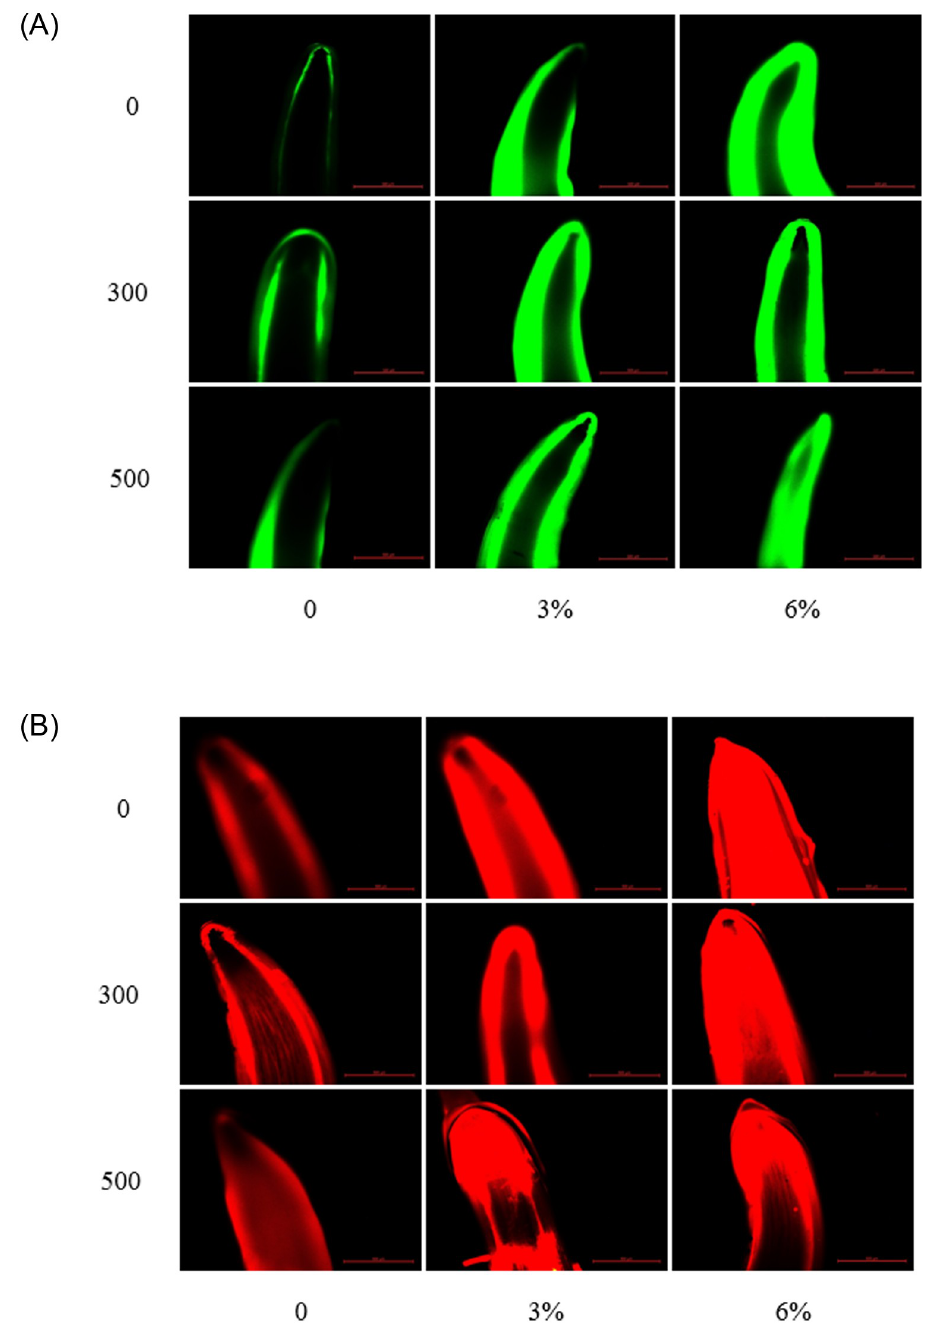
Fig 3. H 2 O 2 and O2 � − staining of soybean radicle root tips under different treatments. H 2 O 2 on the left and O 2 � − on the right. The horizontal axis is PEG concentration, the vertical axis is melatonin concentration, and the scale length is 500 μ